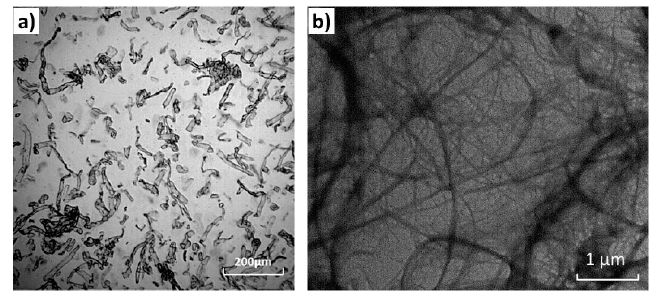
Figure 5. Micrographs of ( a ) micro-cellulose fibers (MFs) from optical microscopy and ( b ) cellulose nanofibrils (CNFs) from transmission electron microscopy. Reprinted from Ding [120].